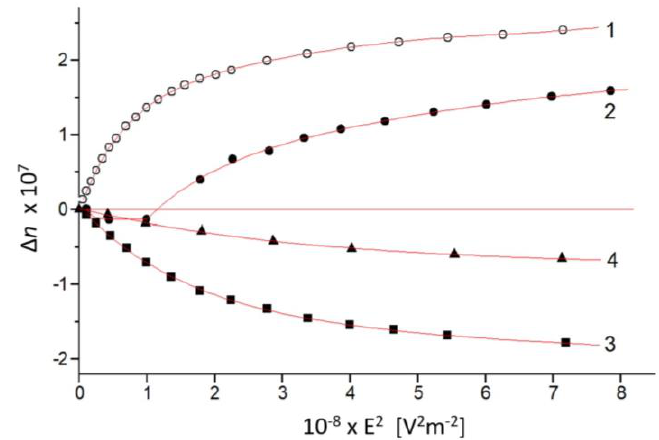
Figure 4. Dependence of the steady-state optical anisotropy ∆ n on the squared strength E of the sinusoidal electric field with a frequency of 1 kHz at a wavelength λ 0 = 650 nm: 1 — PM-water suspension; 2 — PM in 0.3% gel, 5 h old; 3 — PM in 0.4% gel, 3 h old; and 4 — PM in 0.6% gel, 3 h old. The PM concentration in all samples is equal.